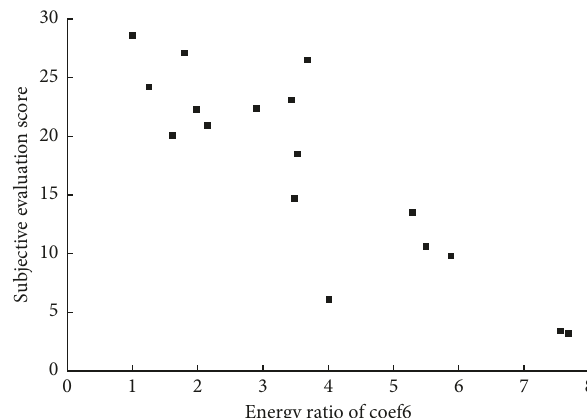
Figure 11: Correlation between the energy ratio coefficient of component 6 and the subjective evaluation value.